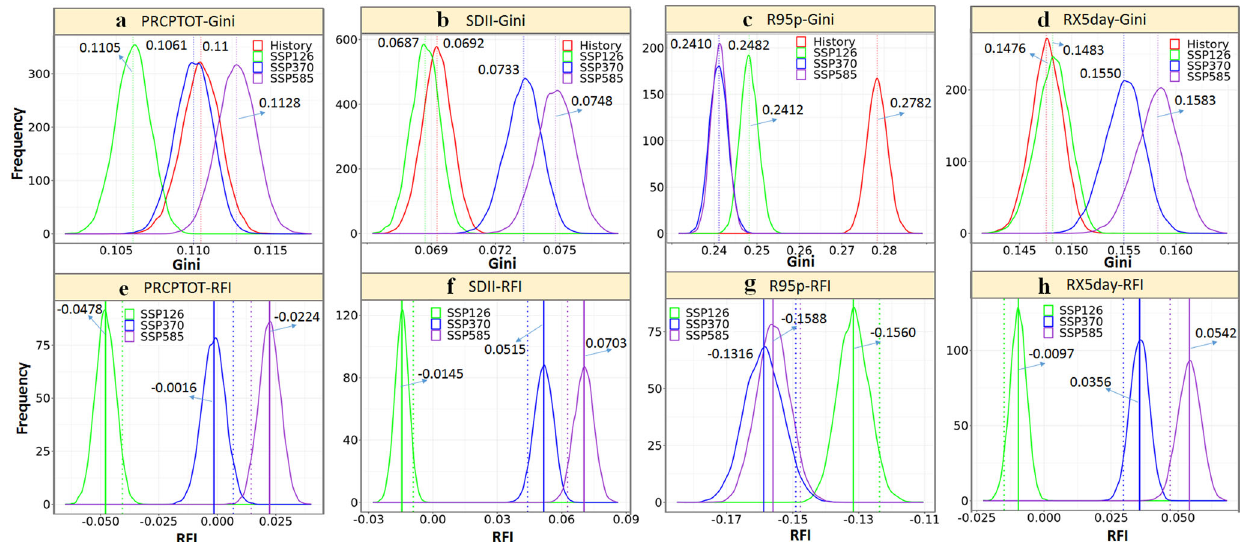
Fig. 5 Maps of the resampled averaged and median (best estimate) Gini-coef fi cients. The fi gure on the top panel represents the probability distribution functions of the resampled averaged Gini-coef fi cients for a PRCPTOT, b SDII, c R95p, and d RX5day over China for historical simulations (1961 – 2005) and future simulations (SSP126, SSP370, and SSP585, from 2051 to 2095), and the dashed line indicates the median (best estimate) value of Gini-coef fi cients. The bottom panel indicates the probability distribution functions of RFI values for e PRCPTOT, f SDII, g R95p, and h RX5day over China as obtained from utilizing the CMIP6 historical and future simulations from the top panels, and the solid straight line indicates the median (best estimate) value of RFI and the dashed line straight indicates the 95th percentile value or 5th percentile value. The sub fi gures were done in the software R 4.0.2 (https://cran.r-project.org/bin/windows/), and then the sub fi gures were merged by using the Microsoft PowerPoint 2013 software (https://www.microsoft.com/).